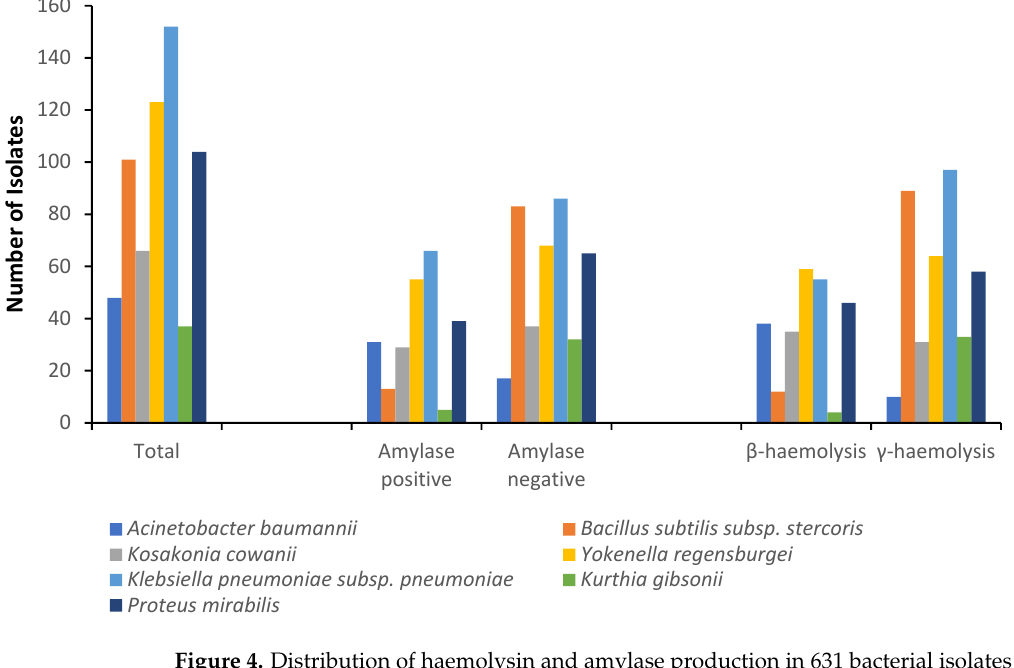
Figure 4. Distribution of haemolysin and amylase production in 631 bacterial isolates from ready-to-eat foods in Lagos, Nigeria.